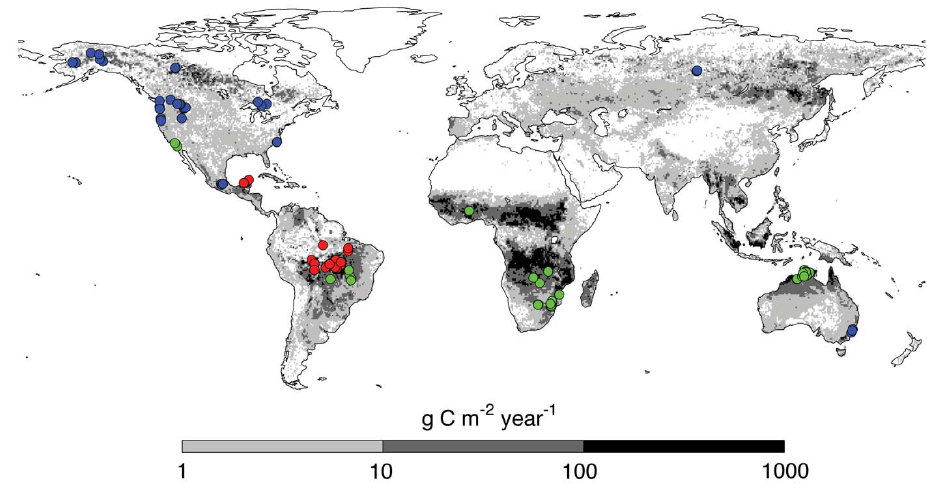
Fig. 1. Locations where simultaneous CO and CO 2 EFs were measured. Locations were stratified by biome following A&M2001–2009; savanna and grassland (green), tropical forest (red), and extratropical forest (blue). Background map shows annual GFED3.1 fire emissions in gCm − 2 year − 1 , averaged over 1997–2008, and plotted on a log